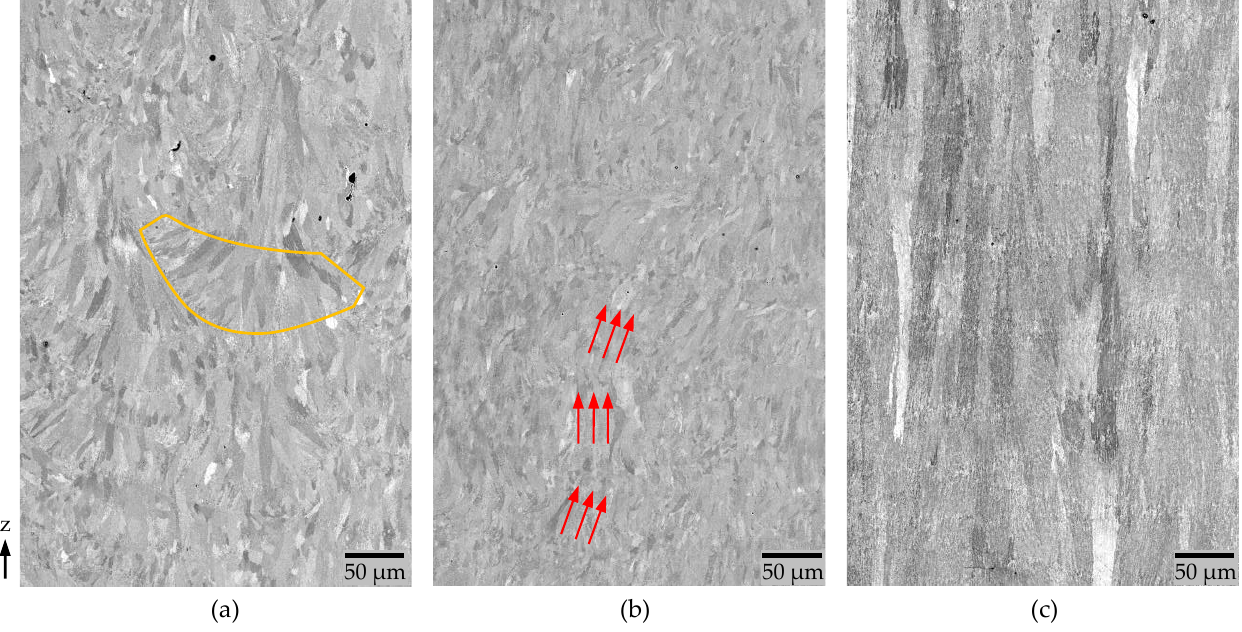
Figure 7. CBS Image taken at a HFH of 500 µm, HV = 10 keV, I = 2.8 nA ( a ) PS 1 melt pool boundaries marked in red, ( b ) PS 2 zig-zag pattern of the grain structure marked in orange, ( c ) PS 3 in the X-Z plane (flipped by 90°).